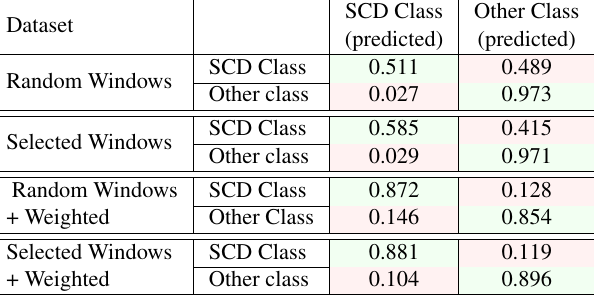
Table 1. Confusion matrices for the biologically-inspired selection and random